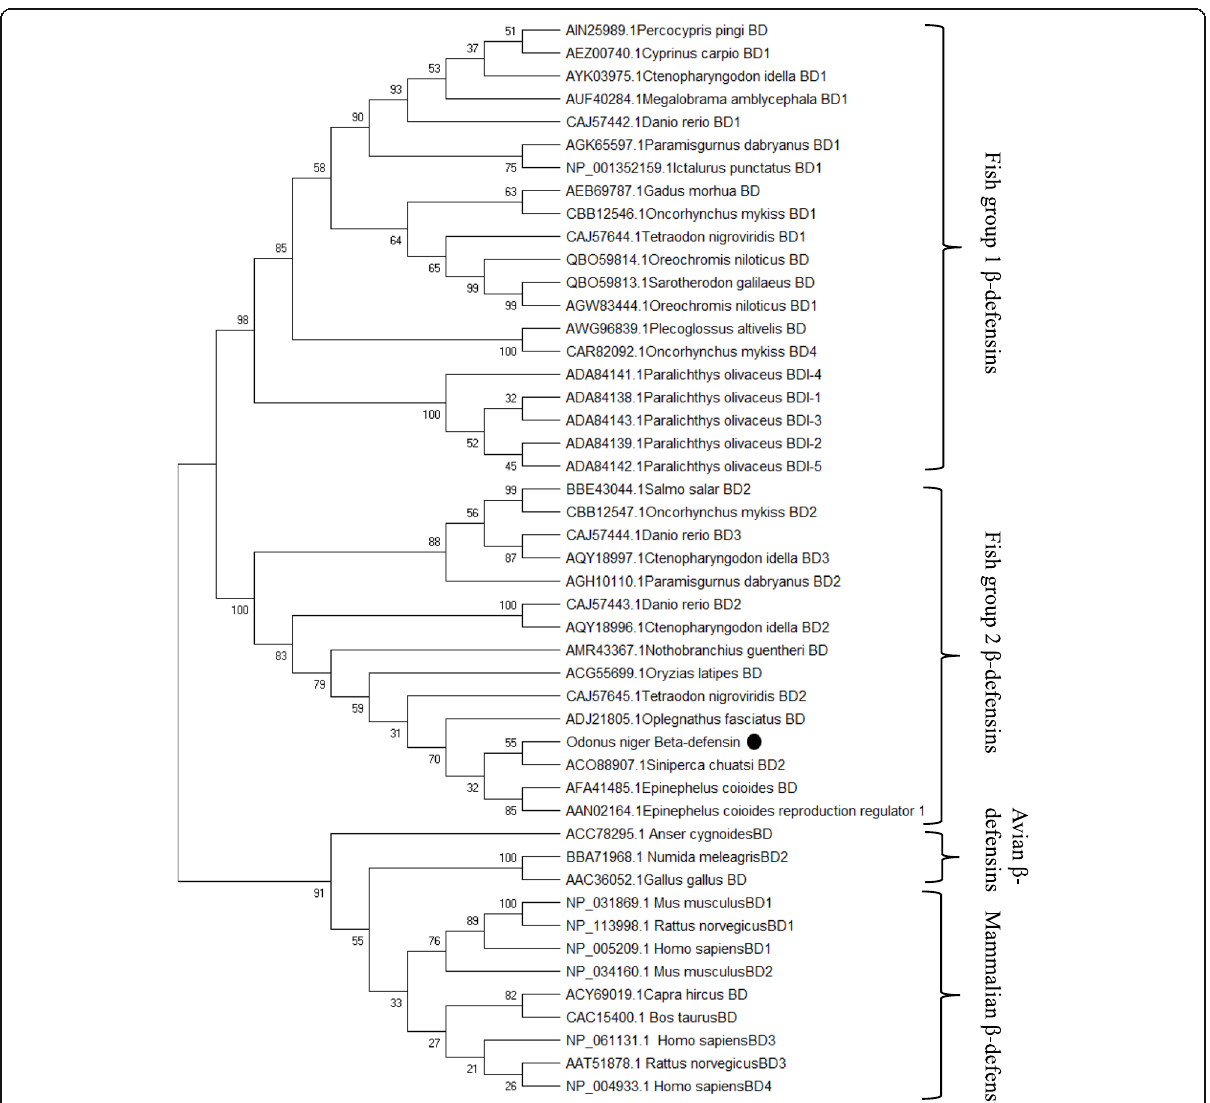
Fig. 4 A bootstrapped neighbour-joining tree obtained using MEGA version X, illustrating relationships between the deduced amino acid sequence of Odonus niger β -defensin ( On -Def) with other β -defensins. Values at the node indicate the percentage of times that the particular node occurred in 1000 trees generated by bootstrapping the original deduced amino acid sequences. Mammalian and bird β -defensins are separated as a branch from the fish β -defensin branch. Within the fish β -defensin branch, sub-branching of group 1 and group 2 are visible. On -Def is marked as ‘ ● ’ , well nested in the fish β -defensin group 2